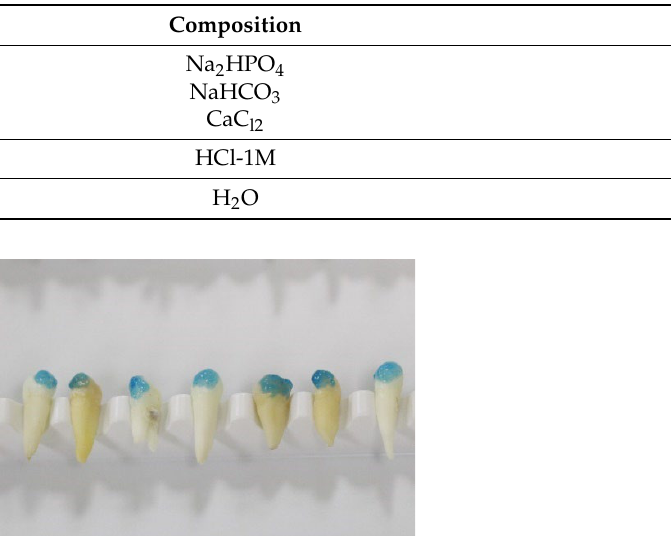
Figure 1. Etched premolars.